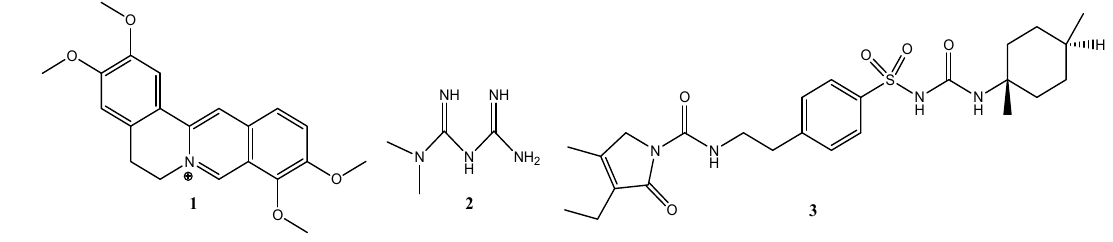
Figure 6. Chemical structures of palmatine ( 1 ), metformin ( 2 ) & glimepiride ( 3 ). However, despite such fundamental differences, all molecules comply with Lipinski’s five rules, i.e., they show good oral bioavailability. The rules of bioavailability of Ghose, Veber, and Muegge are met only for palmatine ( 1 ), while compounds ( 2 ) and ( 3 ) do not fully meet these conditions. Additionally, the program SwissTargetPrediction indicated for compounds a high probability of interaction with various molecular targets like hydrolase, kinase, cyto ‐ chrome P450, and family A G protein ‐ coupled receptors (Figure 7). Figure 7. The target classes of palmatine ( 1 ), metformin ( 2 ), and glimepiride ( 3 ). 3. Discussion T2DM is distinguished by three major defects: abnormal pancreatic insulin secretion, increased hepatic glucose uptake, and peripheral insulin resistance [2]. At a molecular level, insulin resistance is associated with the impairment of the glucose transport system, which shows a reduction of the intracellular pool of transporters [6,19]. The molecular signaling pathway of insulin consists of a series of activations of genes that eventually lead to the stimulation of GLUT4. It may be an insulin ‐ dependent or insulin ‐ independent pathway. The insulin ‐ dependent pathway involves the proteins IRS ‐ PI3K ‐ PKC ‐α ‐ AKT ‐ GLUT4, while the insulin ‐ independent pathway utilizes the protein AMPK [20,21]. The impairment of these insulin signaling pathways is the major cause of T2DM. Ac ‐ tivation of inactivation of these major proteins through phosphorylation or dephosphor ‐ ylation plays a role in aggravating insulin signaling abnormalities that lead to insulin re ‐ sistance [22]. Hence, compounds that increase the peripheral sensitivity to insulin are use ‐ ful in the treatment of T2DM. The inhibition of the PI3K/AKT insulin signaling pathway is caused by the upregulation of serine/threonine protein kinases such as the PKC ‐α and PKC ‐α isoforms [23,24]. This study evaluated the insulin ‐ dependent signaling pathway with a focus on the IRS1, PI3K, PKC ‐α , AKT2, and GLUT4 genes. The skeletal muscle is the largest (by mass) organ of the human body and is the primary site of glucose uptake, disposal, and storage, accounting for approximately 75% of the entire body’s glucose uptake under insulin stim ‐ ulation [25]. As a result, maintaining normal glucose levels requires proper skeletal tissue function [26,27]. The L6 skeletal muscle cell line and skeletal muscle tissue from STZ ‐ in ‐ duced diabetic rats were used in this investigation because they express a high level of GLUT4, which is required for glucose absorption from the plasma. The diabetic control